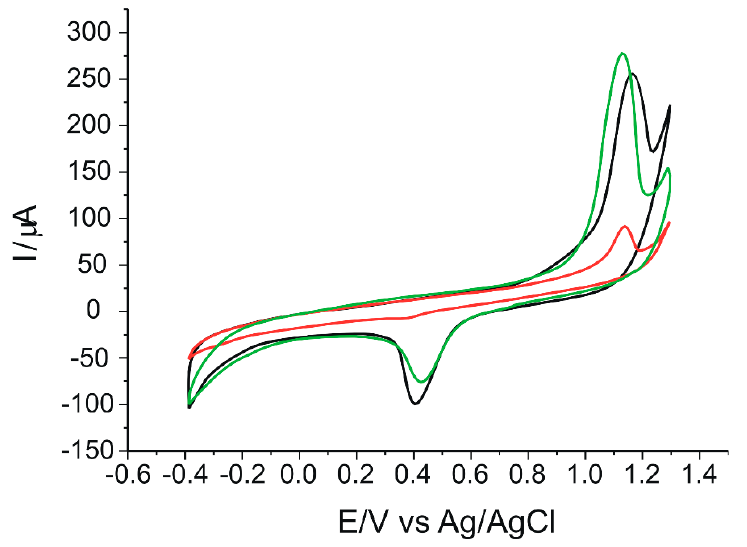
Figure 1. Voltammetric responses of CNT-GNP/SPCE (red line), CNF-GNP/SPCE (black line) and GPH-GNP/SPCE (green line) towards extract of EVOO sample v1. Scan rate: 0.1 V·s − 1 .